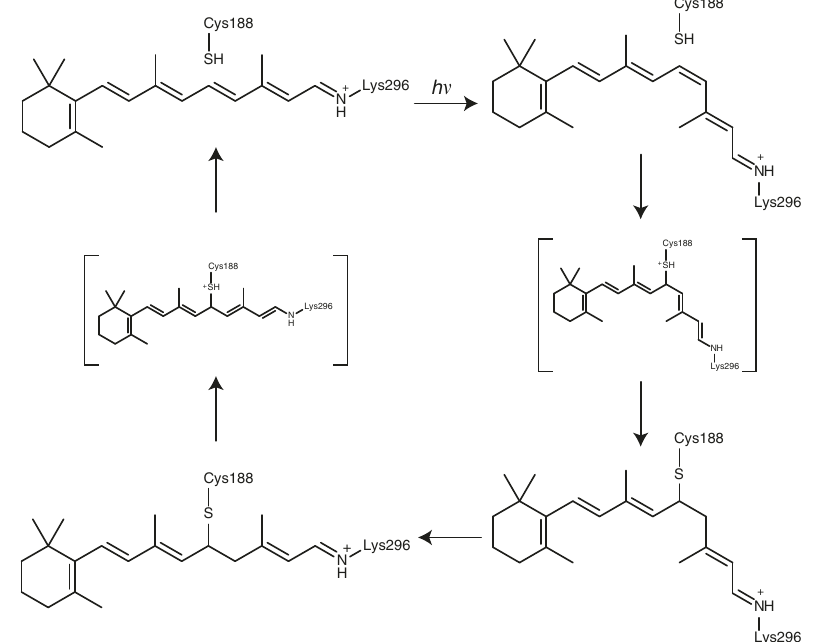
Fig. 6 Chromophore structural changes in the photocycle of Opn5L1. Opn5L1 has all- trans -retinal as a chromophore, near which cysteine residue at position 188 (Cys188) is situated (top left). Light causes all- trans -to-11- cis isomerization of the chromophore (top right). The isomerization is followed by adduct formation between the chromophore and the thiol group of Cys188, resulting in conversion of C11 = C12 double bond to a single bond in the chromophore (bottom right). As the C11 − C12 single bond is thermally rotated, adduct dissociation occurs when the C11 − C12 bond is in a trans conformation (bottom left). Subsequent reformation of the all- trans -retinal chromophore recovers the original state of Opn5L1 (top